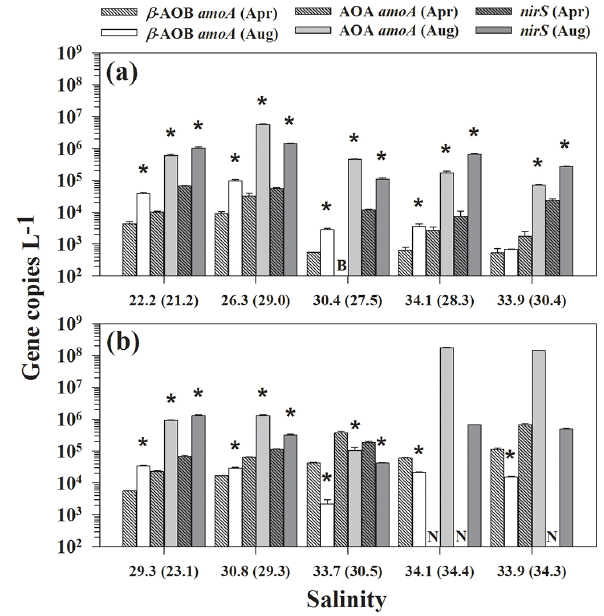
Fig. 7. β -AOB and AOA amoA and nirS gene abundances from the free-living (0.2 ∼ 3µm) communities along the salinity tran- sect in April and August (between parentheses). Error bars indicate standard deviation. Asterisks indicate statistically significant differ- ences between the April and August samples. (a) and (b) represent the surface and bottom samples. B: below detection limit; N: not detected due to lack of enough environmental